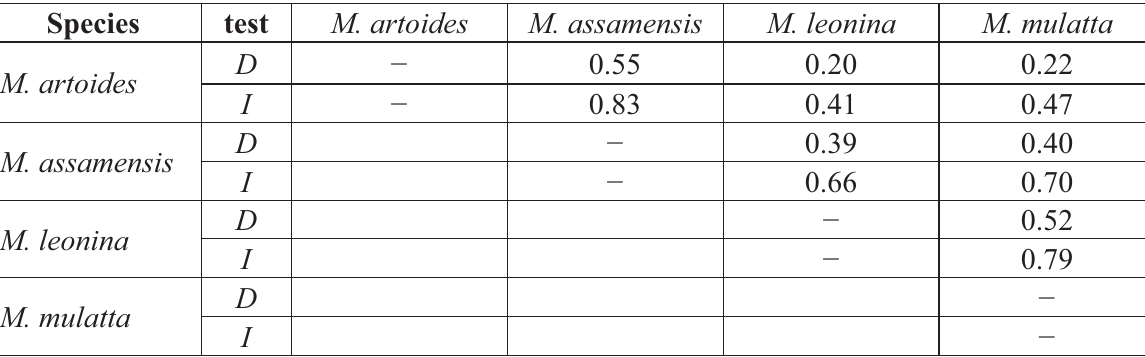
Table 6. Pair-wise niche similarity statistical test ( D , I ) scores.